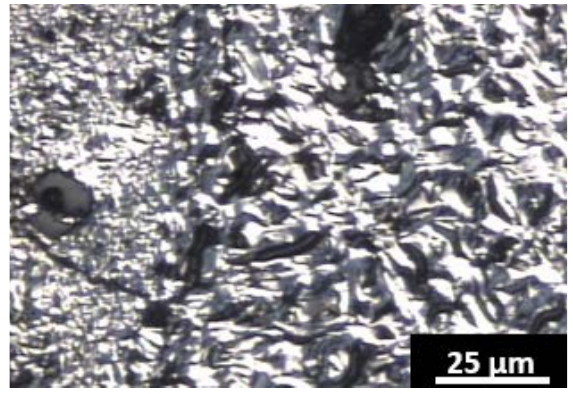
Figure 5. Polarized light micrograph of anthracene-fluorene coke after furnace heat treatment at 2600 ◦ C for 1 h.